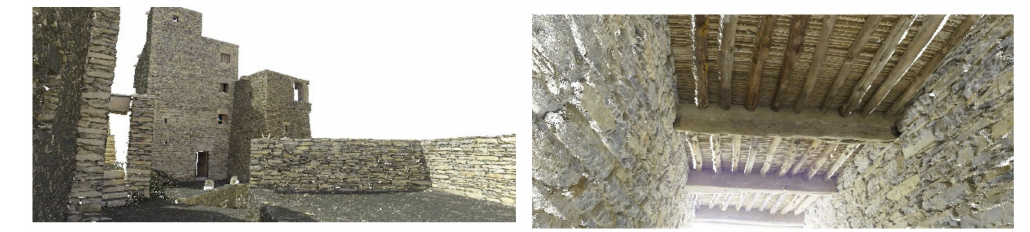
Figure 5. Examples show interior and exterior 3D colored point